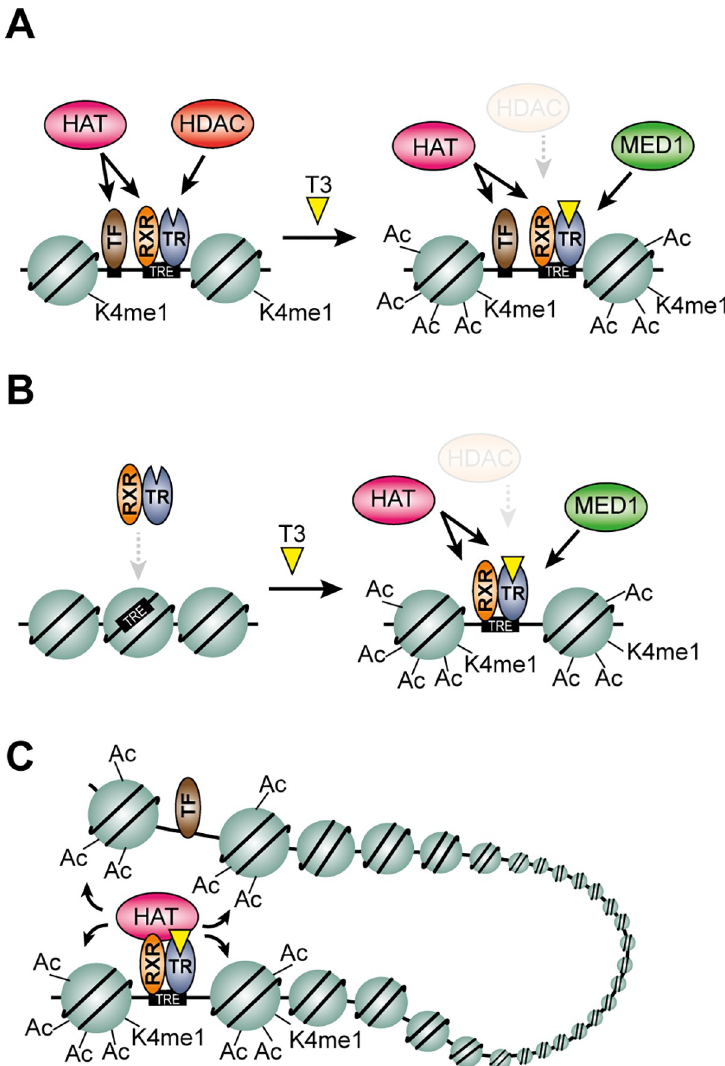
Fig 6. Models describing T3-dependent H3 hyperacetylation and activation of enhancers. (A) Poised enhancers (type 1A) are hyperacetylated as a result of HDAC3 disassociation from the TRBS. As HDAC3 occupancy is reduced, histone acetylation increases as a result of pre-occupied HATs. In addition, MED1 is recruited to the enhancers in a T3-dependent manner. (B) Dormant enhancers (type 1B) are hyperacetylated as a result of T3-dependent TR and HAT recruitment to chromatin. Activation of these enhancers is associated with increased chromatin accessibility, H3K4me1 and MED1 recruitment. (C) A subset of T3-activated enhancers is not occupied by TR yet activated in a TR- dependent manner. These enhancers are connected to TR occupied enhancers either though long-range interaction within TADs or local interaction within SEs. The TRE illustrates the TR response element, which predominantly consists of DR4